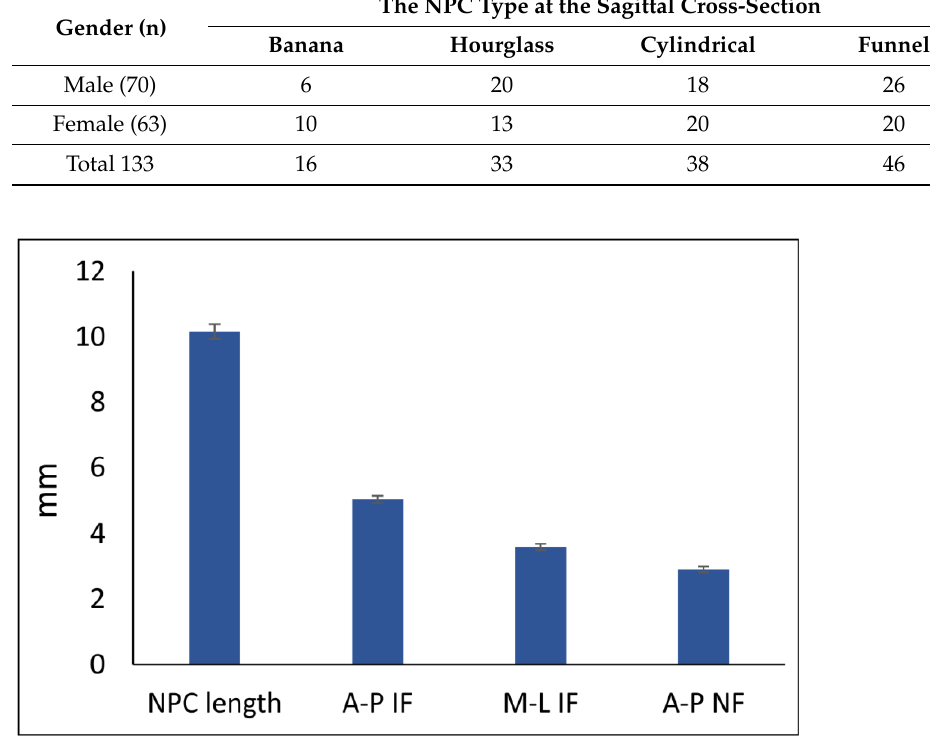
Figure 3. The morphometric parameters predefined for NPC.